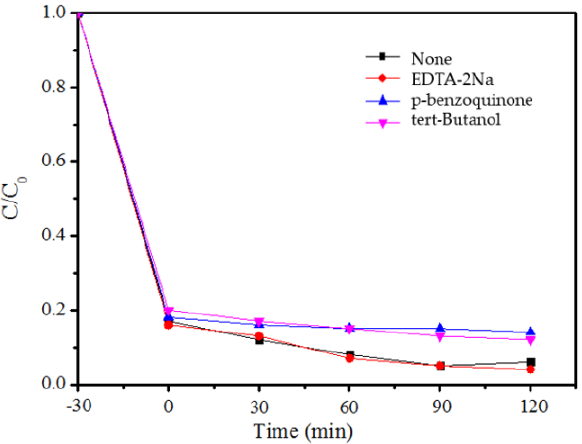
Figure 8. The capture experiments of MB by B-TiO 2 /C 3 N 4 .